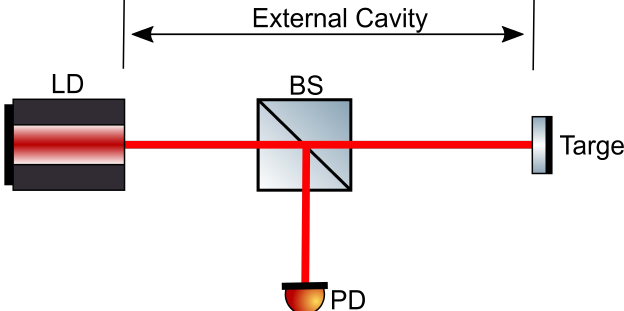
Figure 1. Schematic diagram of a laser diode (LD) with the external optical feedback (EOF)